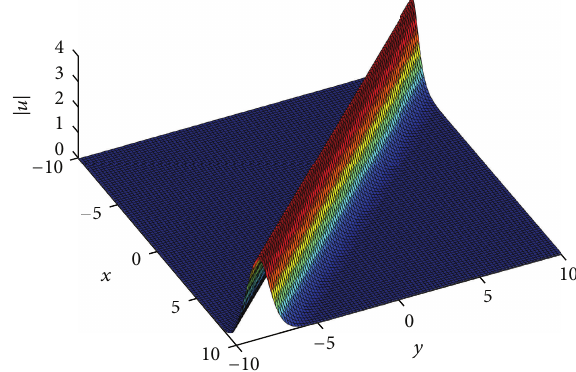
Figure 3: Soliton solution |𝜓| 2 at 𝑡 = 0 .